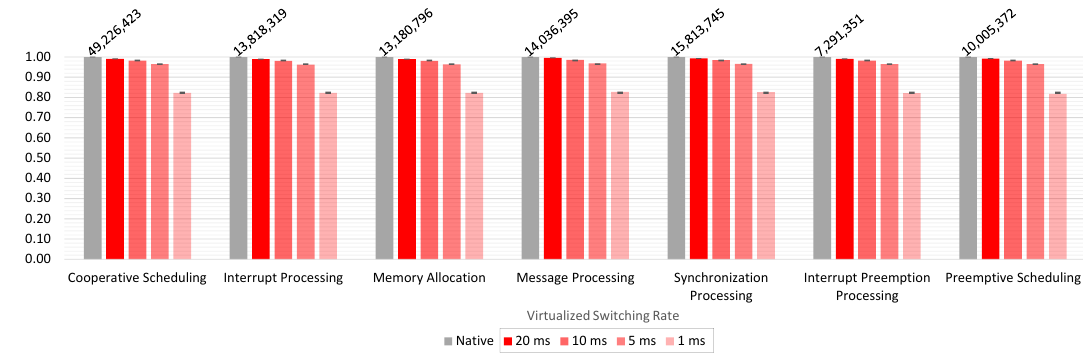
Figure 6. Thread-Metric Benchmark results, comparing the native execution of a FreeRTOS guest against its virtualized execution with different